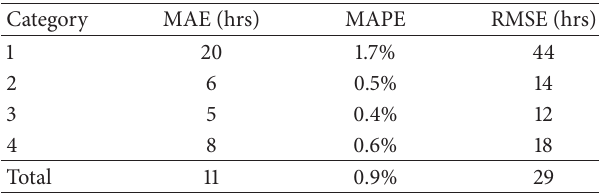
Figure 6: The forecasting results using PCA-FCM-BPN.